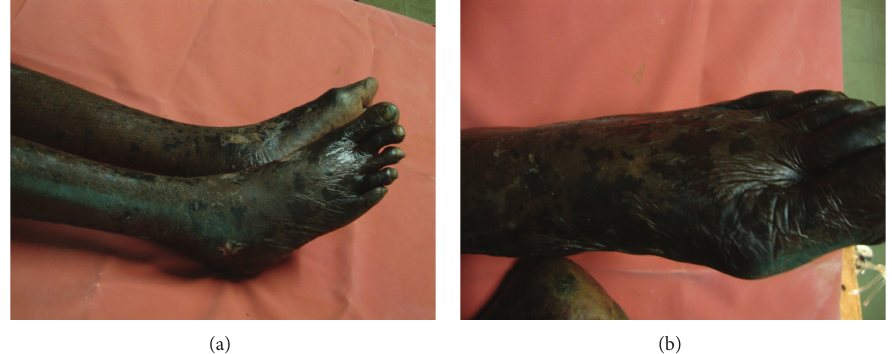
Figure 1: (a) Blotchy purpuric rash over both lower limbs mainly in the extremities, with some healed areas 48 hours after doxycycline therapy. (b) Closer view of left foot showing involvement of all toes and dorsum of foot, with some healed lesions showing